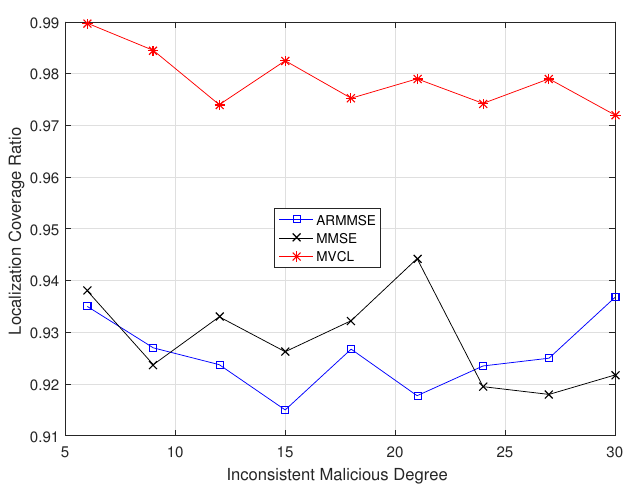
Figure 17. Localization coverage ratio with inconsistent malicious degree ζ ( n = 80, m = 20, R = 30, k = 4, η = 3).